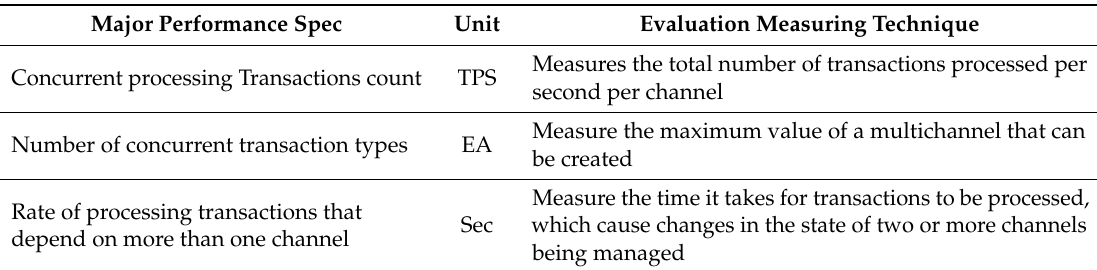
Table 1. Experimental conditions for performance evaluation.